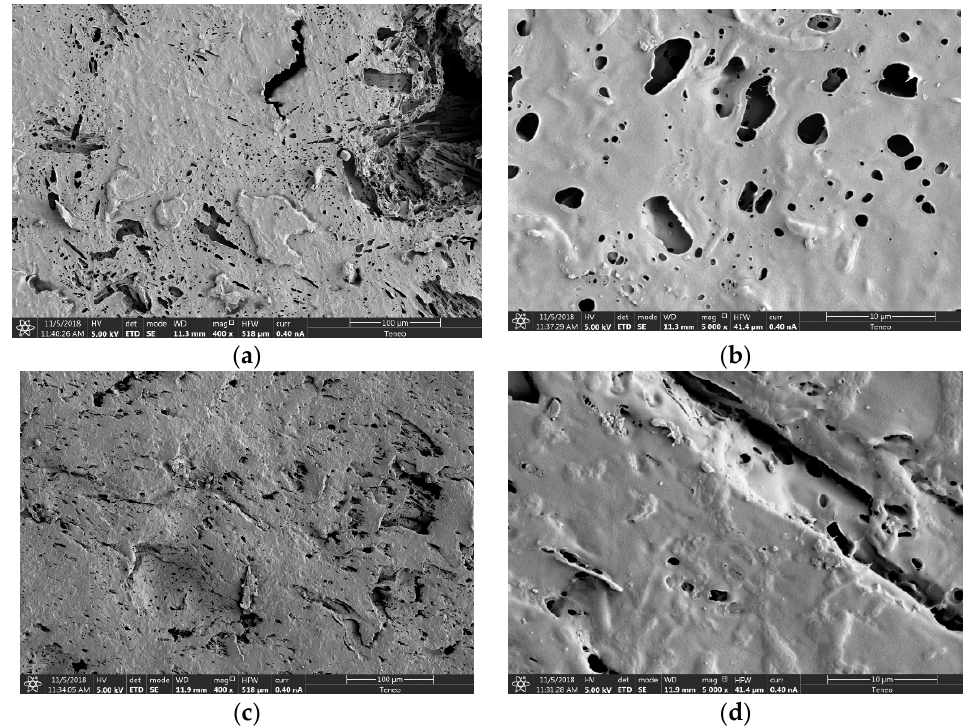
Figure 8. SEM images of PBS_CL tablets obtained by USAC (47/53% v/v) and filament obtained by HME (45/55% v/v) after drug release. ( a , b ) USAC tablets at 400× and 5000×; ( c , d ) HME filament at 400× and 5000×.